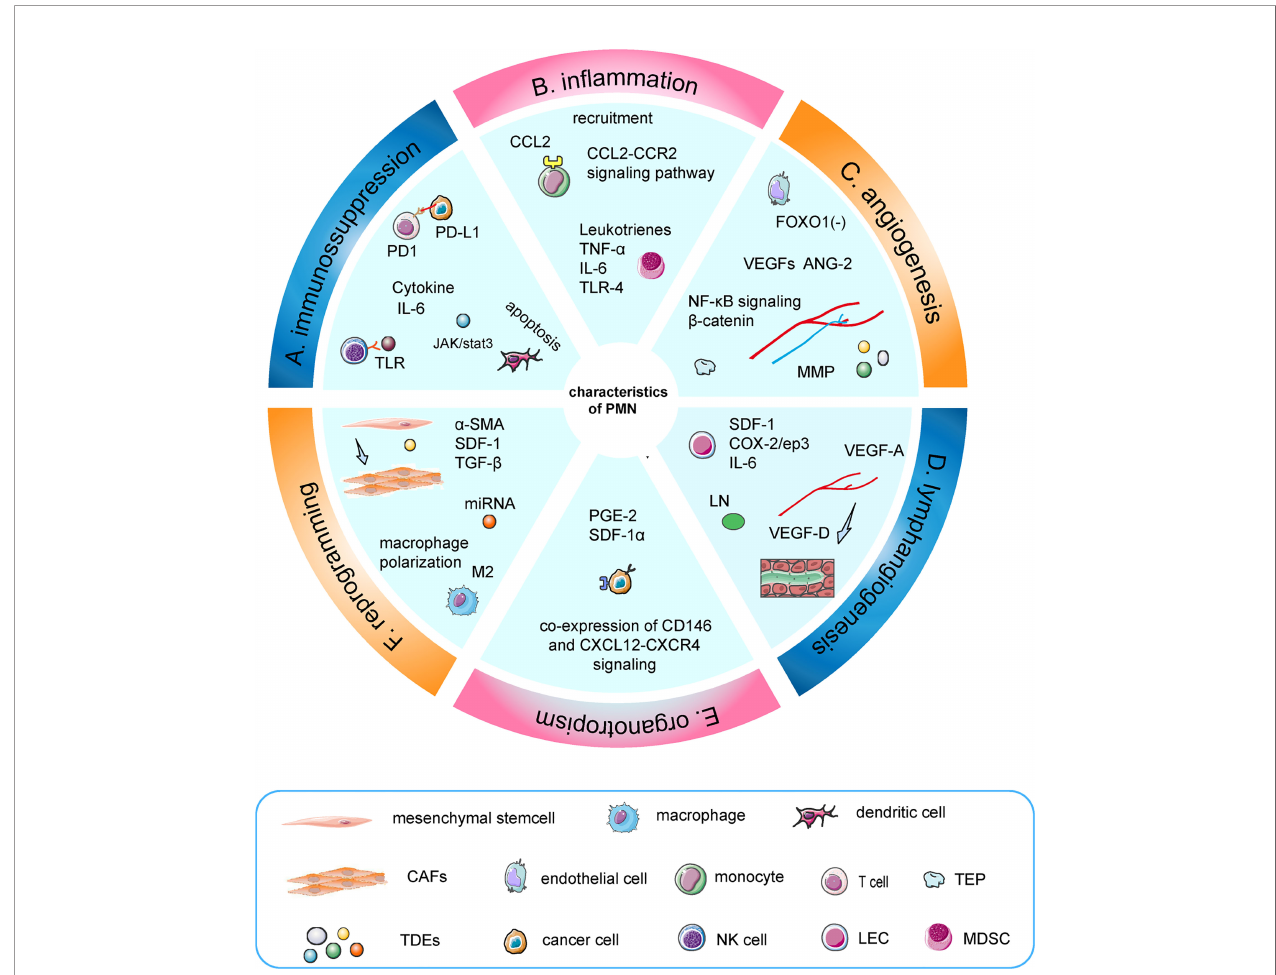
FIGURE 1 | Characteristics of the PMN. (A) TDEs induced apoptosis of dendritic cells, increased secretion of IL-6, and inhibited the function of T cells and NK cells. (B) TNF- a induced S100A8-SAA3-TLR4 signaling and maintained an in fl ammatory state, which was mediated by MDSC. Similarly, IL-6, leukotrienes, and CCL2 – CCR2 signaling pathways were involved. (C) Upregulation of angiopoietin-2 and VEGFs could regulate the angiogenic switch, in which TEPs and MMPs had a synergistic effect. Moreover, miR-135b promotes angiogenesis by inhibiting FOXO1 expression in endothelial cells. (D) VEGF-A and VEGF-D are crucial factors in the induction of premetastatic lymphangiogenesis. Furthermore, dendritic cells induce a PMN during LN metastasis through COX-2/ep3-dependent induction of SDF-1. (E) Tumor cells interacted with resident mesenchymal stem cells/pericytes around the surrounding blood vessels to achieve organotropism through co-expressed CD146 and Sdf-1/CXCL12-CXCR4 signaling. (F) Exosomes induced the transformation of mesenchymal stem cells into CAFs and macrophage M2-like